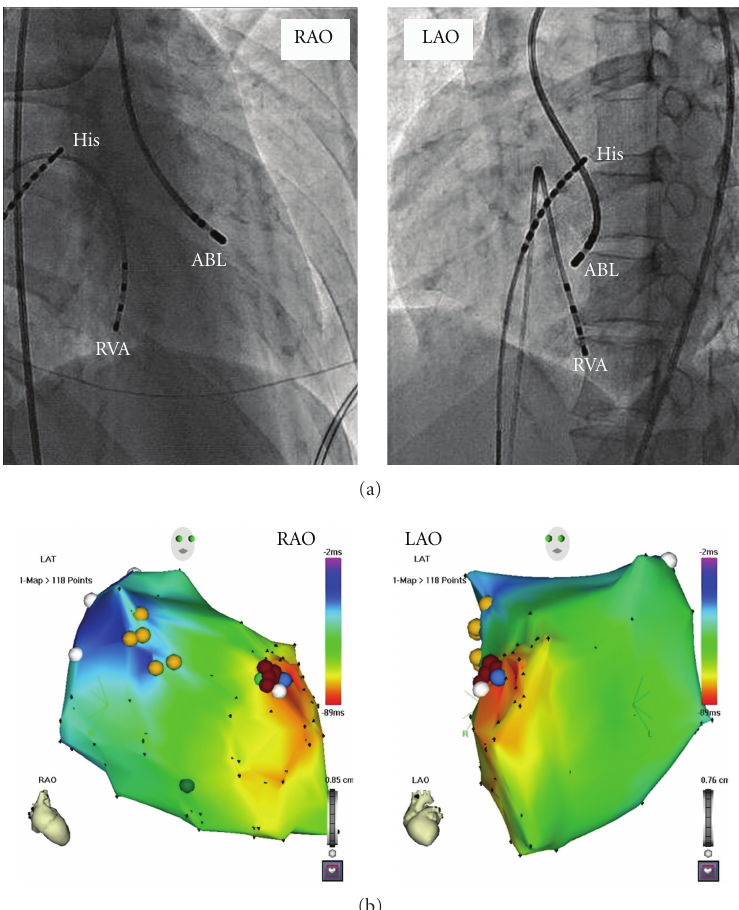
Figure 2: Fluoroscopic images (a) and 3D electroanatomic map (b) of the LV demonstrating the successful ablation site. ABL: ablation catheter; His; His bundle catheter; RVA: right ventricular apex; RAO: right anterior view; LAO: left anterior view.